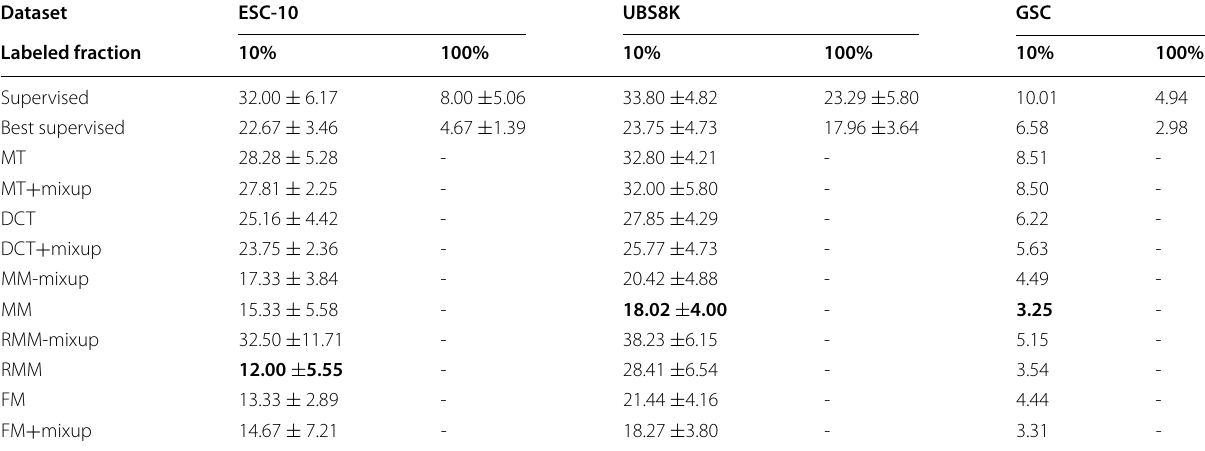
Table 5 Semi-supervised learning error rates (%) on ESC-10, UBS8K, and GSC